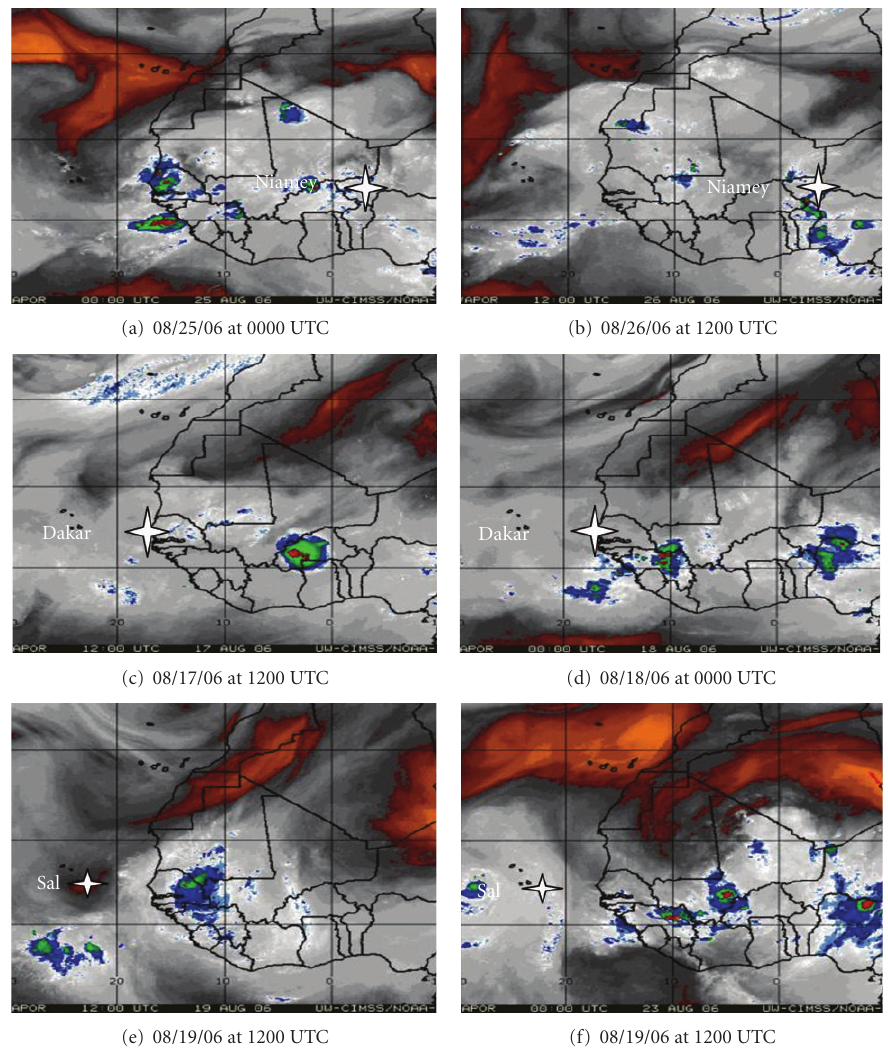
Figure 2: Images Meteosat-8-Upper Level Water Vapor in Niamey (a) and (b), Dakar (c) and (d), and Sal (e) and(f) 00 UTC and 12 UTC. The orange color represents the very dry air associated with airborne dust. The colors green, blue, and red represent areas of deep convection. (source: